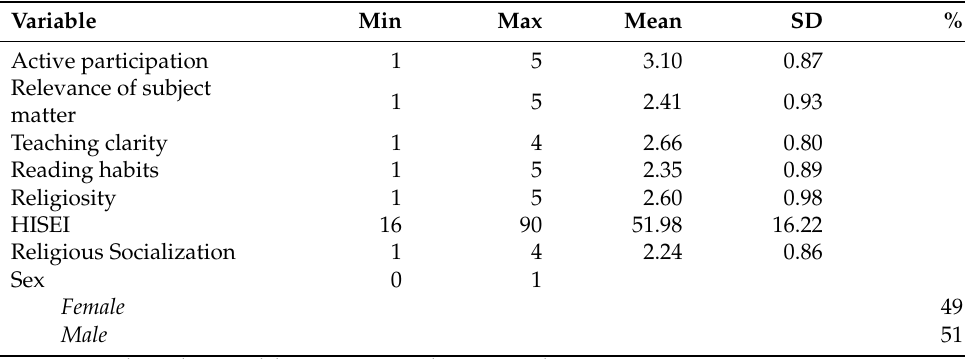
Table 1. Descriptive statistics of the included